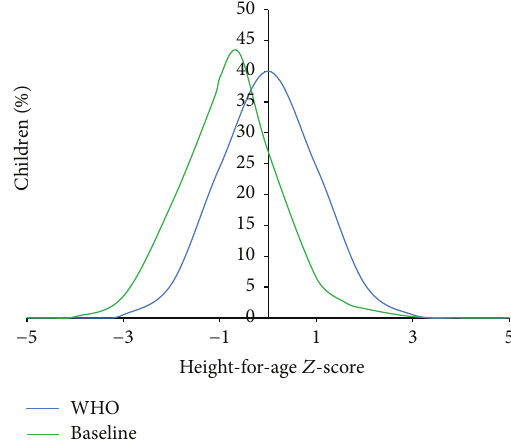
Figure 1: Distribution of the index height-for-age in schoolchildren studied at baseline compared to the reference population